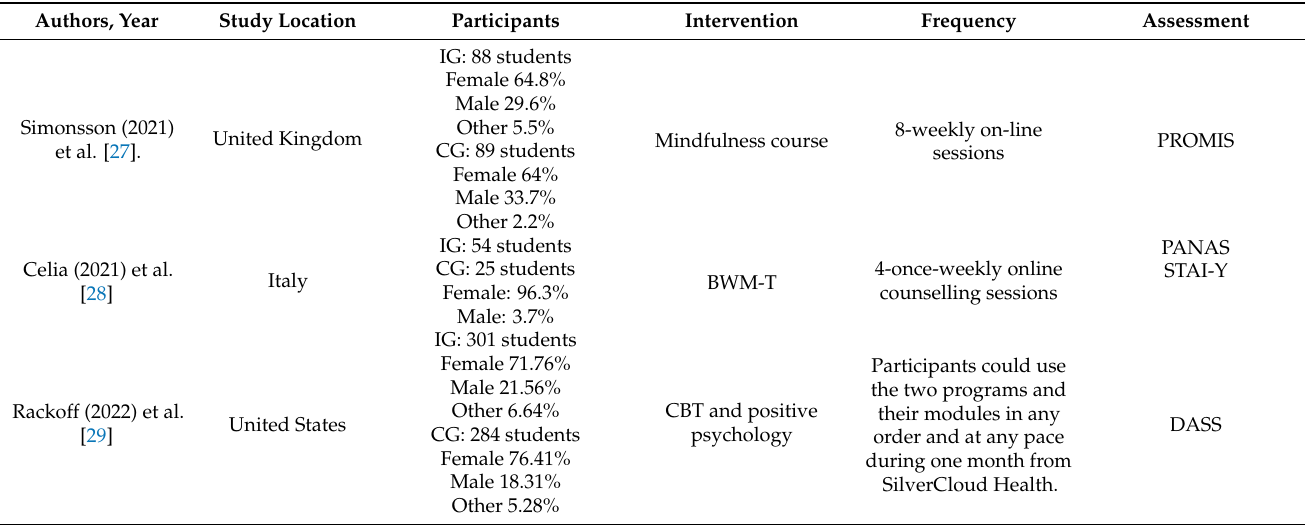
Table 1. Characteristic of included studies.